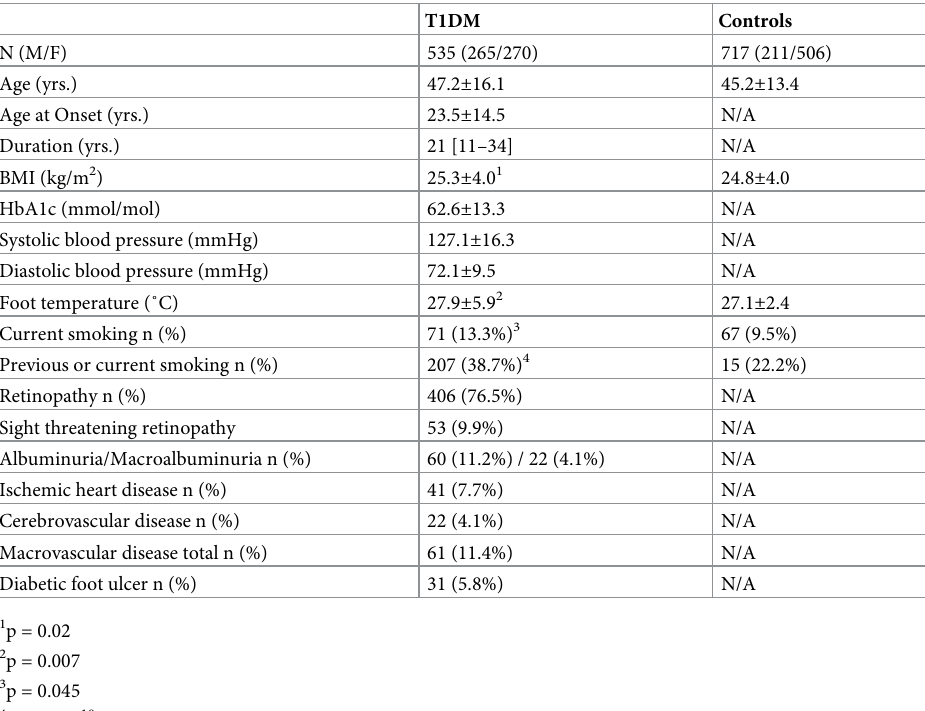
Table 1. Characteristics of study